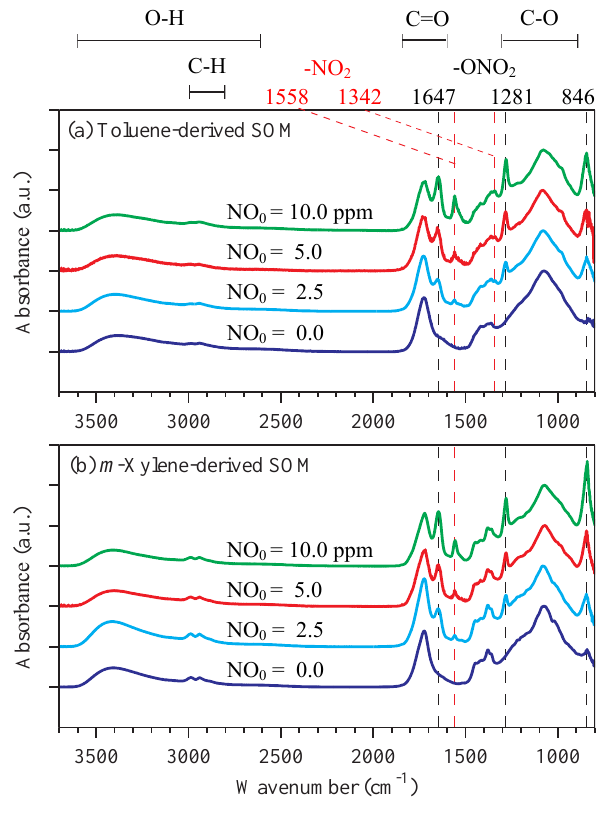
Figure 6. Infrared spectra of (a) toluene-derived SOMs and (b) m -xylene-derived SOMs for several different initial NO concen- trations. Individual curves are offset from each other so that dif- ferences can be seen. Spectra are normalized to the peak height at 1100cm − 1 , corresponding to a C–O stretch, to compensate for dif- ferent masses on the filter samples.